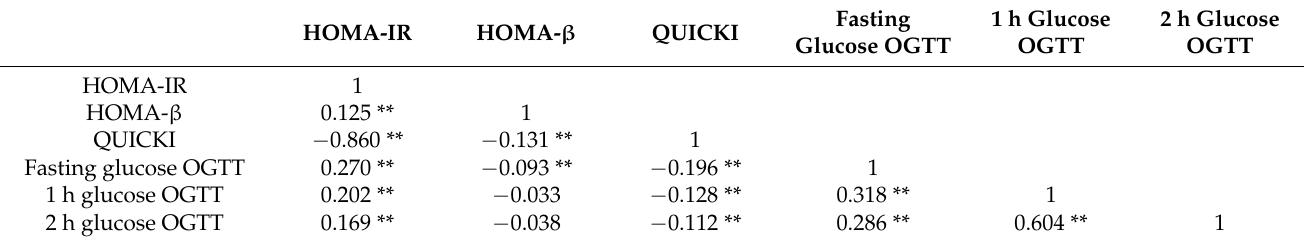
Table 2. Partial correlation analysis of insulin sensitivity in early pregnancy and serum glucose at gestational weeks 24–28 a